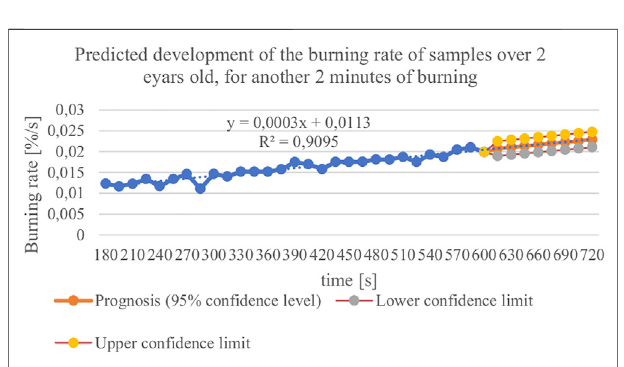
FIGURE 8 | Predicted development of the mass loss rate of samples over 2 years